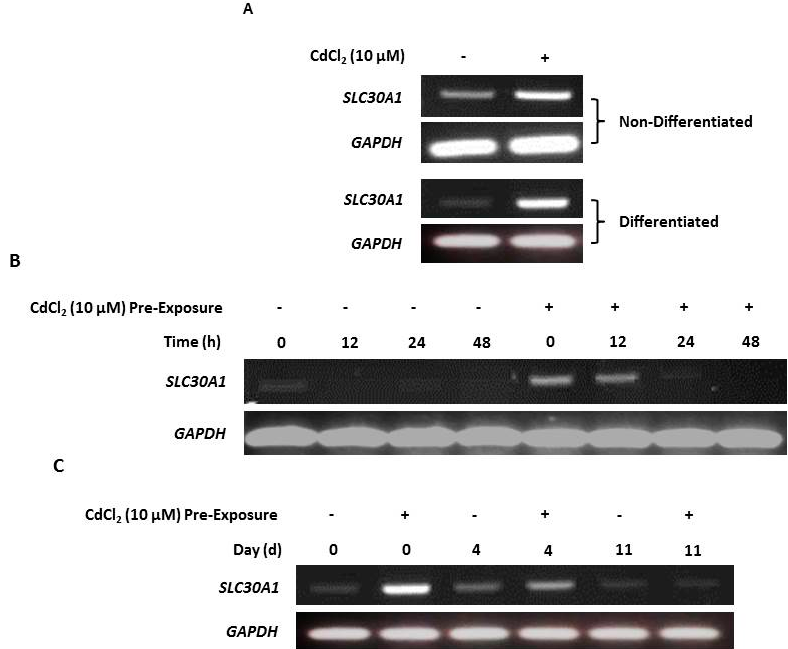
Figure 5. Cadmium induction of zinc transporter-1 ( SLC30A1 ) gene transcription. SLC30A1 gene